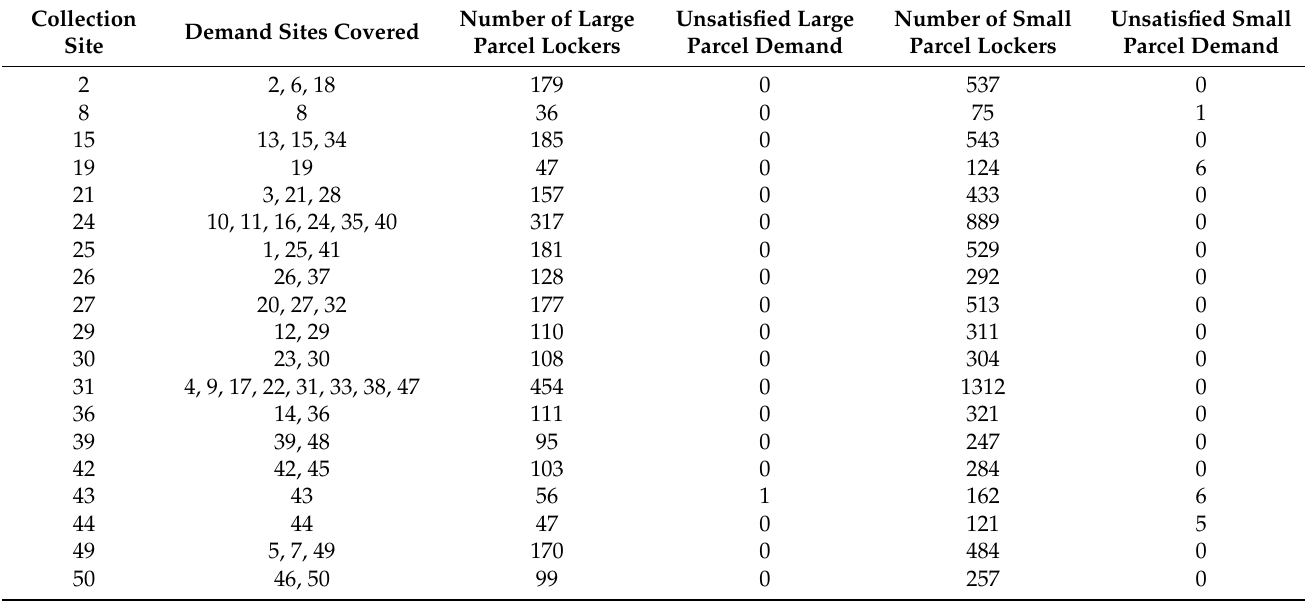
Table 3. Results obtained for the parcel locker location problem with Γ =